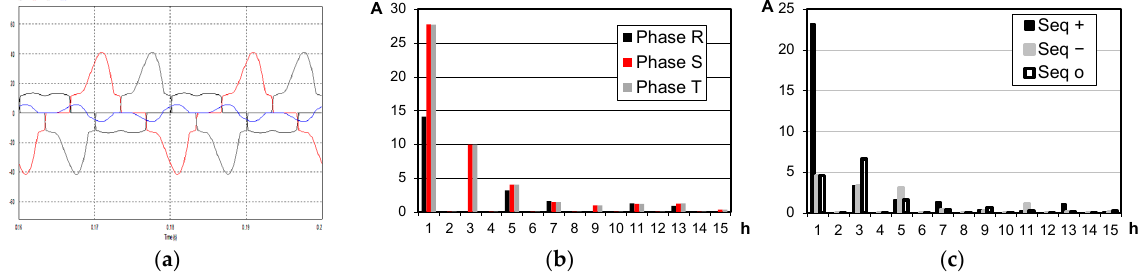
Figure 17. Case E - ( a ) supply currents (phases R , S , and T and neutral); ( b ) harmonic spectrum of phase components; ( c ) harmonic spectrum of the symmetric components.